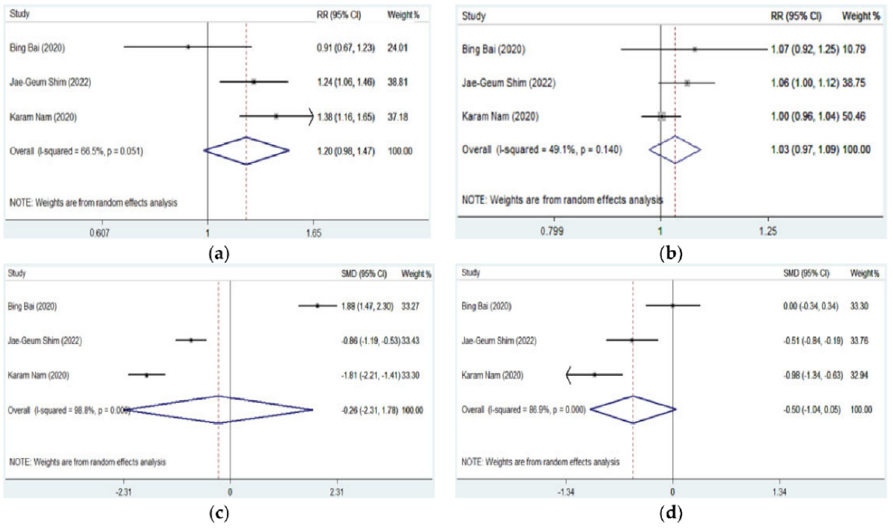
Figure 3. Forest plots for the efficiency outcomes of artery catheterization guided by DNTP vs. palpation approach [7,8,11–15]. ( a ) First-attempt success of DNTP vs. palpation; ( b ) subgroup analysis by patient age in first-attempt success of DNTP vs. palpation; ( c ) subgroup analysis by catheter size in first-attempt success of DNTP vs. palpation; ( d ) overall success of DNTP vs. palpation; ( e ) subgroup analysis by patient age in overall success of DNTP vs. palpation; ( f ) subgroup analysis by catheter size in overall attempt success of DNTP vs. palpation; ( g ) cannulation time of DNTP vs. palpation; ( h ) sub- group analysis by patient age in cannulation time of DNTP vs. palpation; ( i ) subgroup analysis by cath- eter size in cannulation time of DNTP vs. palpation; ( j ) puncture number of DNTP vs. palpation; ( k ) subgroup analysis by patient age in puncture number of DNTP vs. palpation.